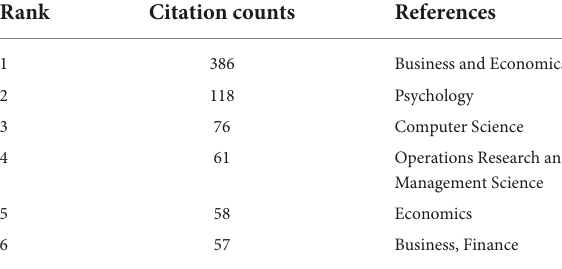
TABLE 3 The most highly co-occurring